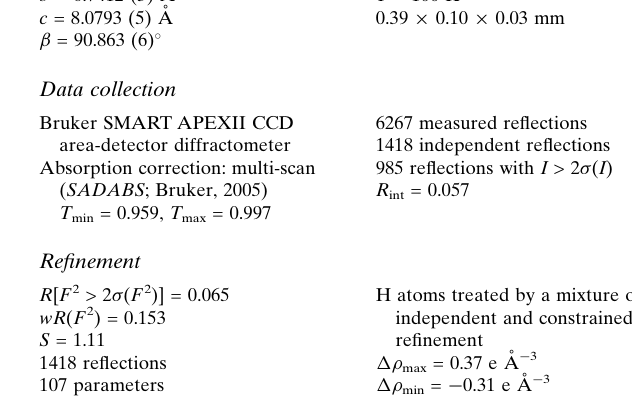
Data collection